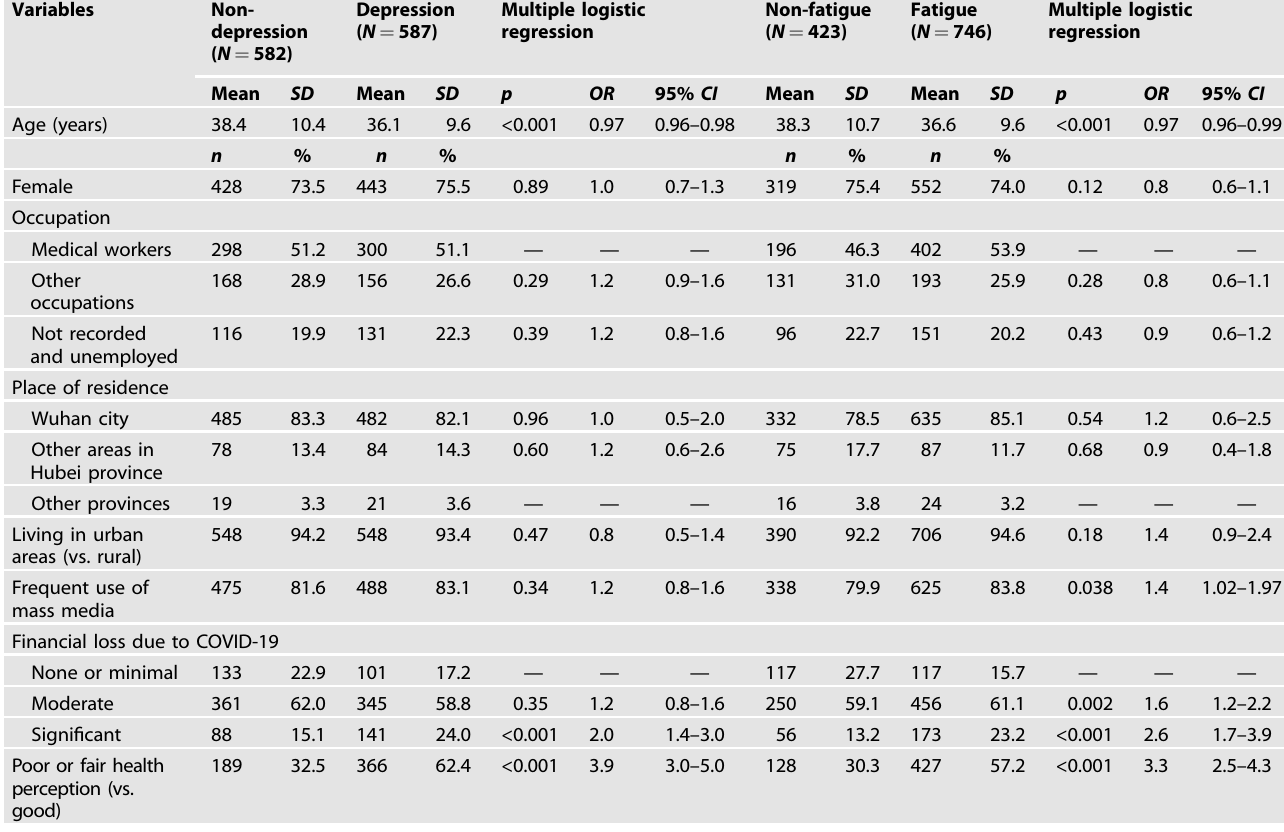
Table 2. Independent correlates of depression and fatigue among close contacts ( N =